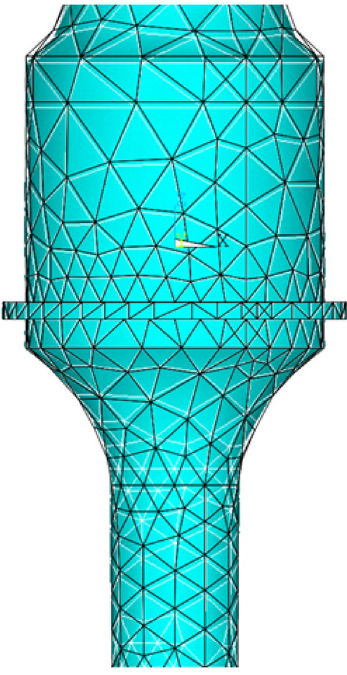
Fig. 6 Generated mesh for